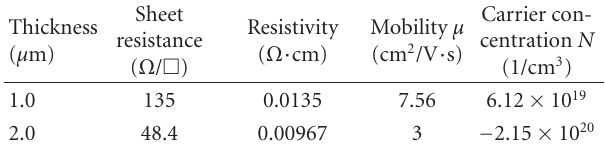
Table 3: EPMA analysis of composition of Al in coatings compared to that in powder target.